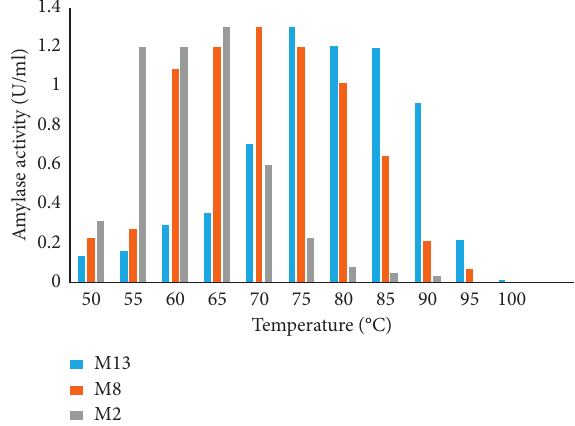
Figure 11: Effect of temperature on amylase activity of M13, M8, and